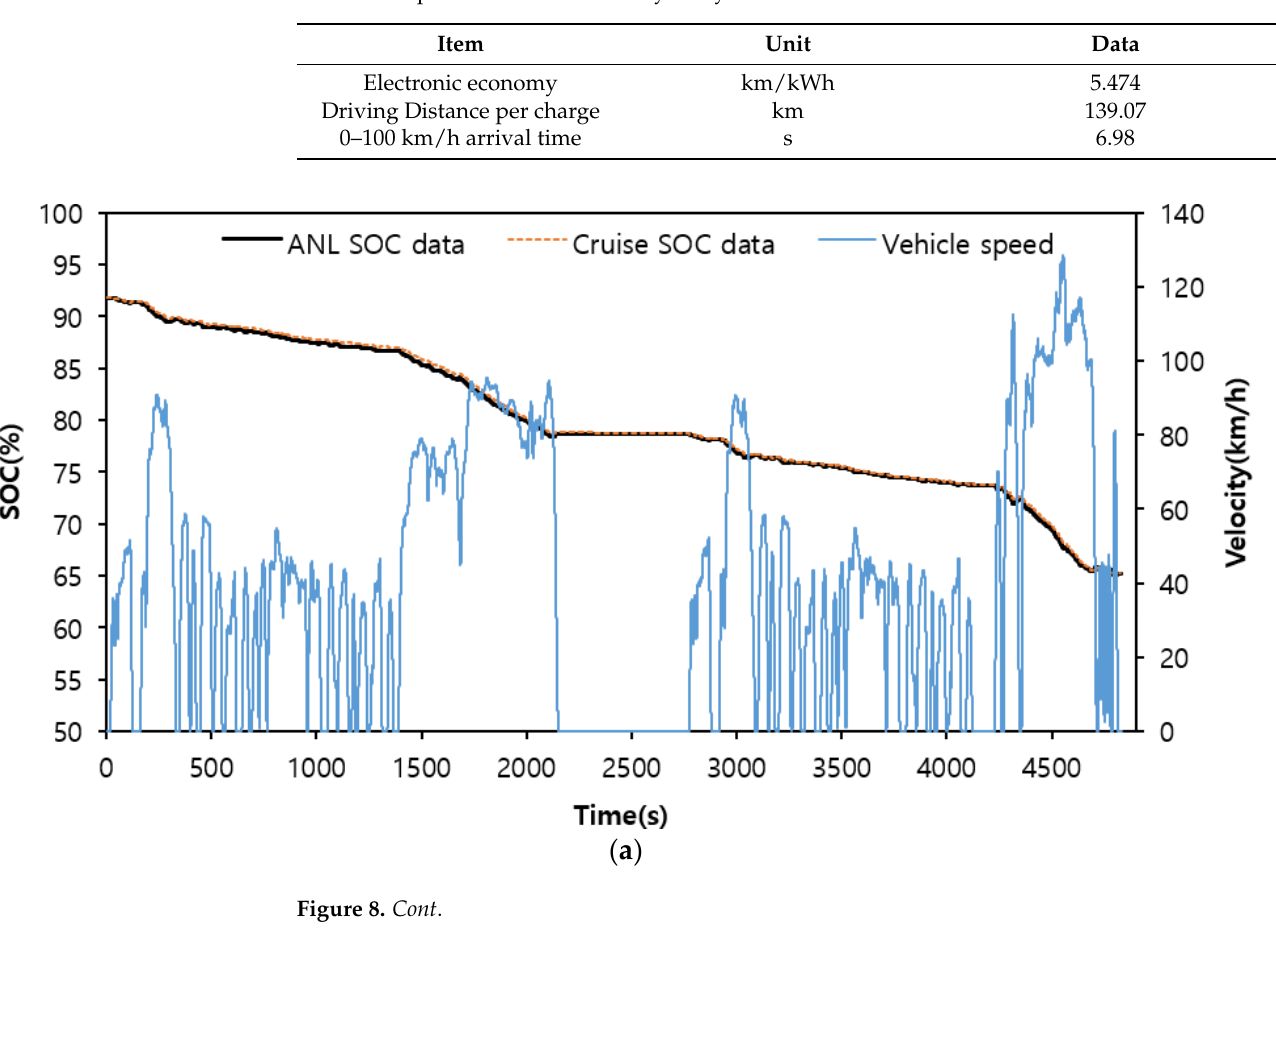
Figure 7. Efficiency of CVT according to shift